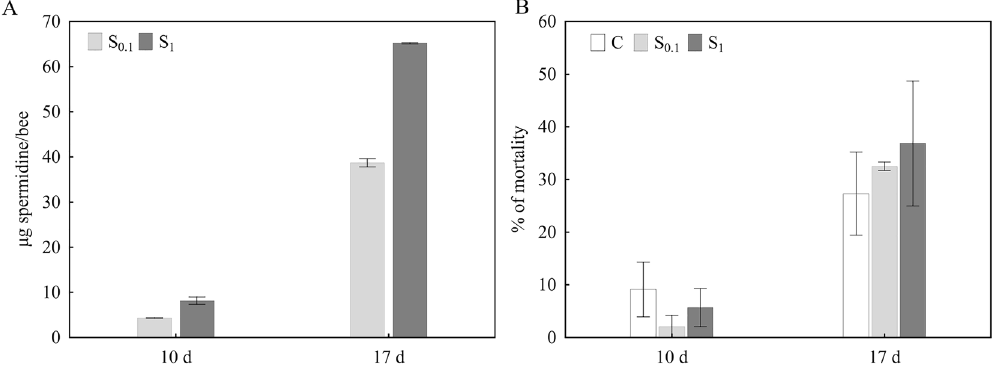
Figure 3. ( A ) Total mass of spermidine in µg which was ingested in 10 (10d) or 17 days (17d) per bee. ( B ) Mortality in analyzed experimental groups after 10 days (10d) and 17 days (17d). Control group C was fed with 50% sucrose solution, while in S 0.1 and S 1 groups diet was supplemented with 0.1 mM and 1 mM spermidine, respectively. Sample size: C 10d (n = 100), C 17d (n = 90), S 0.1 10d (n = 96), S 0.1 17d (n = 80), S 1 10d (n = 102), S 1 17d (n = 87). Mean value ± standard error (SE) is